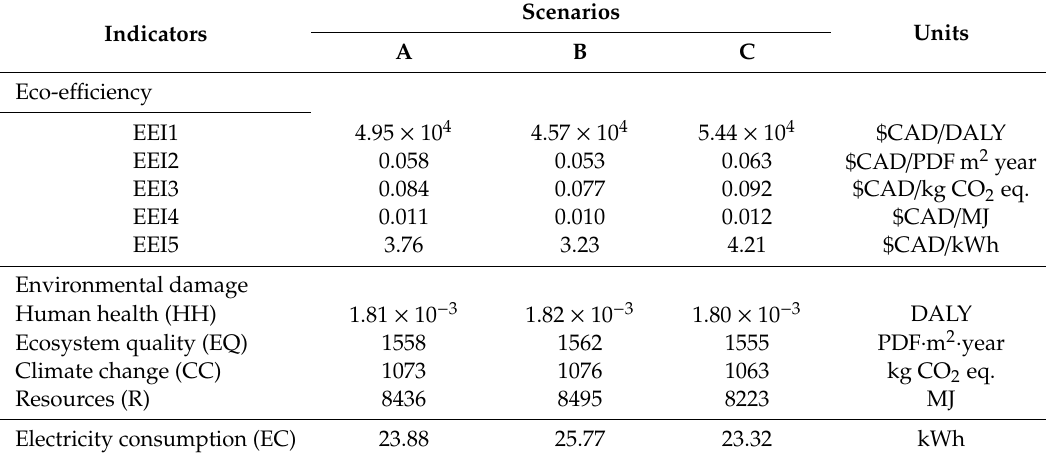
Table 6. Values of the eco-e ffi ciency indicators (EEIs), the potential environmental damages, and the electricity consumptions (ECs) per ton of raw milk received for scenarios A, B, and